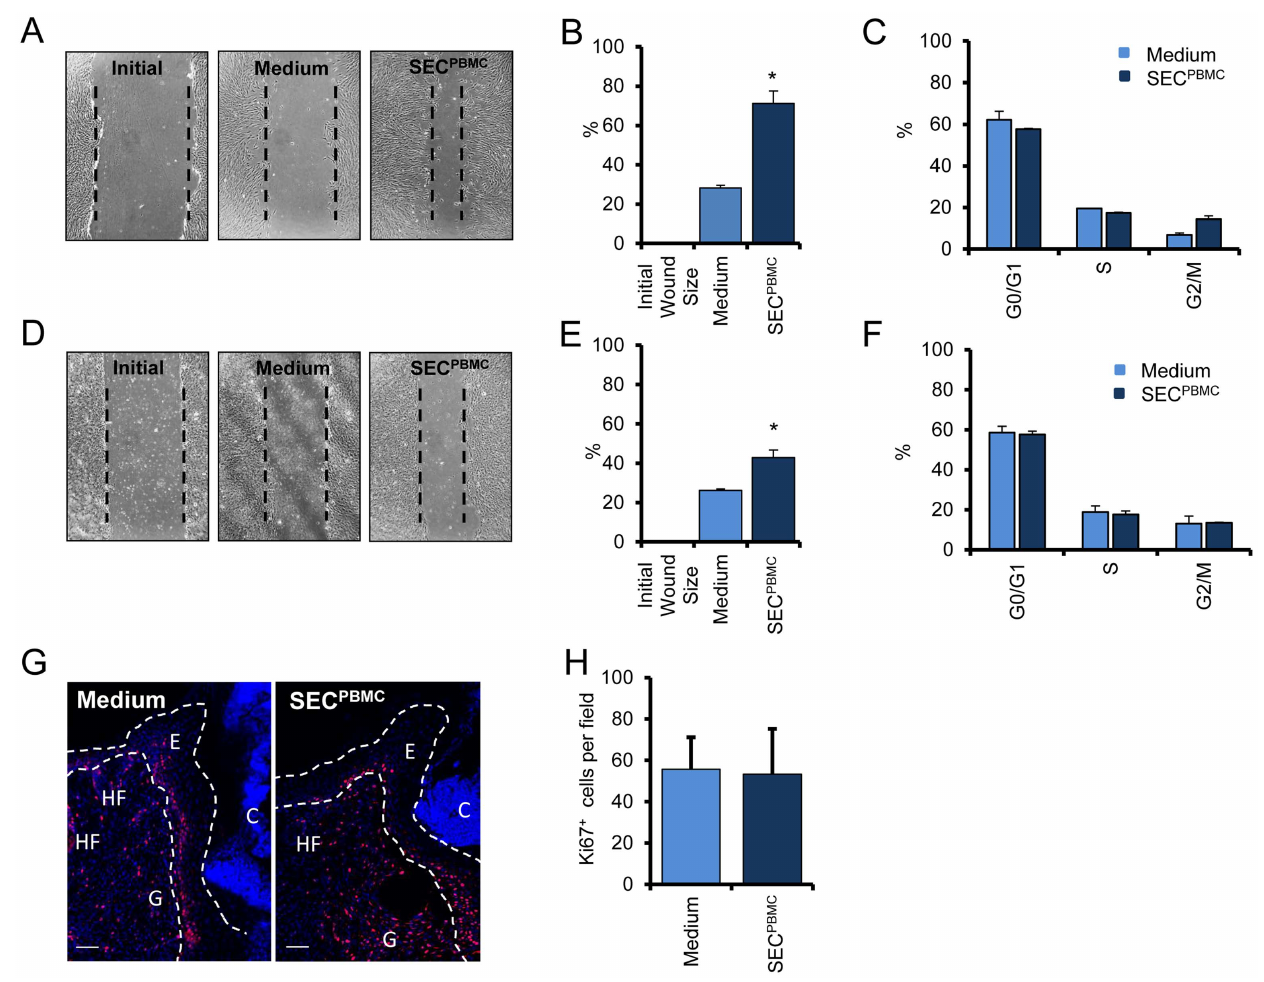
Figure 2. SEC PBMC induces migration of human primary fibroblasts and keratinocytes. Scratch wounds of FB ( A ) and KC ( D ) are shown. One representative experiment of three each done in triplicates is shown. The mean-width of the gaps of nine scratch wounds after 18 h was measured and the percentage of closure for FB ( B ) and KC ( E ) was calculated. (*: p , 0.01). Cells cycle analyses revealed no significant differences in FB ( C ) and in KC ( F ). One representative experiment of three each done in triplicates is shown. ( G ) Ki67 staining of medium and SEC PBMC treated wounds showed no significant alterations in proliferating cells. Photographs were taken at the wound-edge of wounds 7 days after wounding. Ki67 staining is shown in red and nuclear staining is shown in blue. C = crust, E = newly formed epidermis, G = granulation tissue HF = hair follicle. One representative animal of 15 is shown. Scale bars: 50 m m. ( H ) The mean from 15 animals per group of Ki67 positive cells at the wound edge of one high power image was calculated.